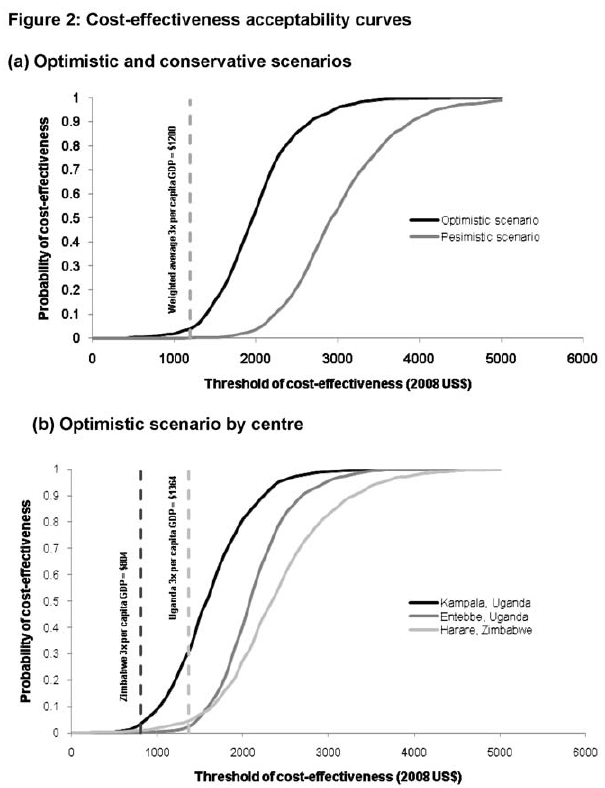
Figure 2. Cost-effectiveness acceptability curves.